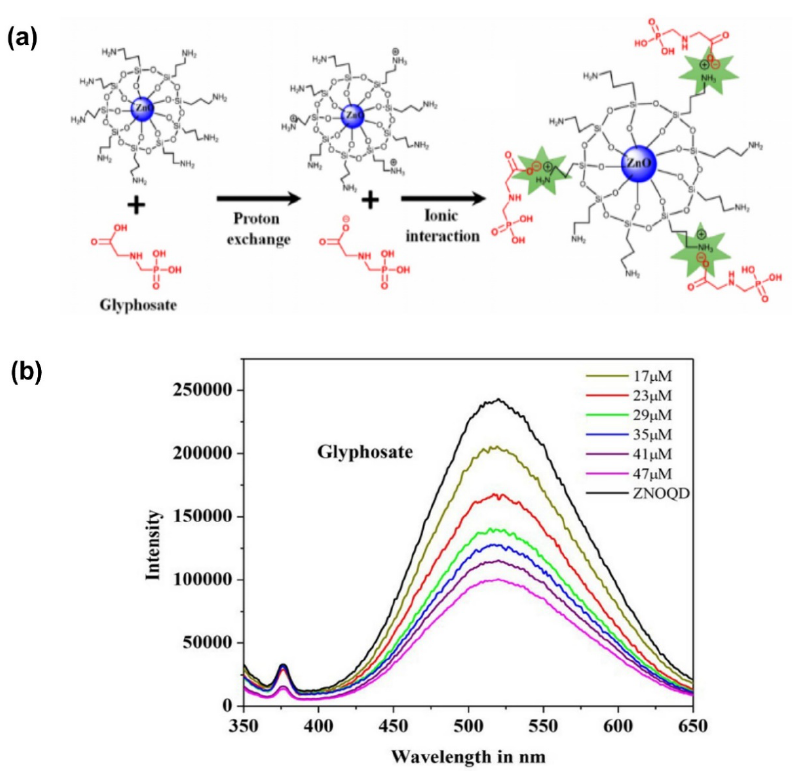
Figure 16. ( a ) Schematic Representation of Interaction of QD with Glyphosate, ( b ) Emission spectra ( λ ex = 340 nm) of ZnO QD (5 × 10 –5 M) in the presence of different GLYP concentrations. Reprinted with permission from [155]. Copyright 2018 ACS Publications.